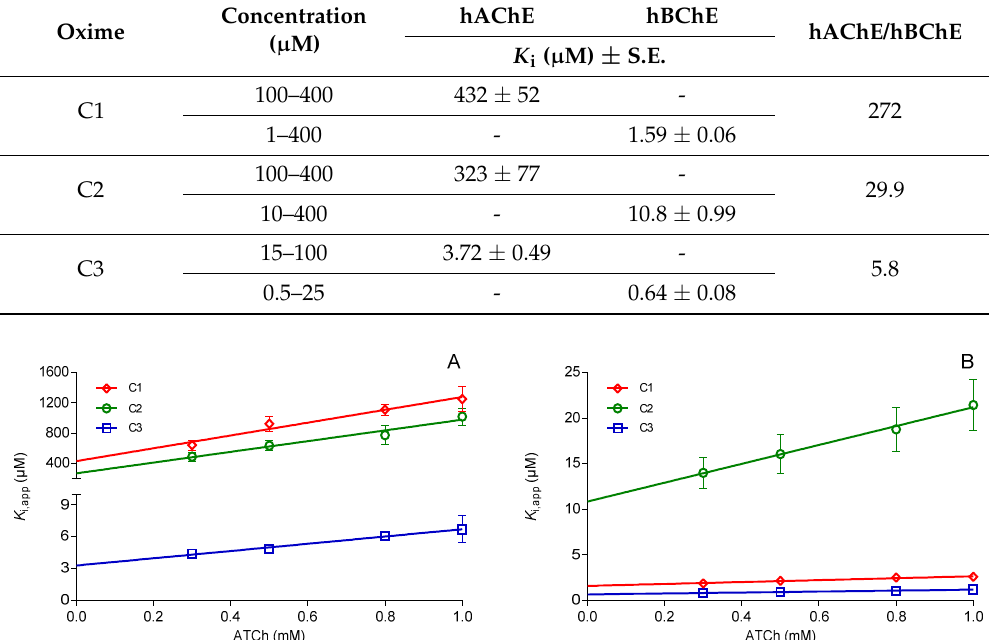
Table 2. Reversible inhibition of hAChE and hBChE by the tested oximes. Dissociation inhibition constants ( K i ) was evaluated from at least three experiments studied in 0.3–1.0 mM substrate ATCh concentration range.